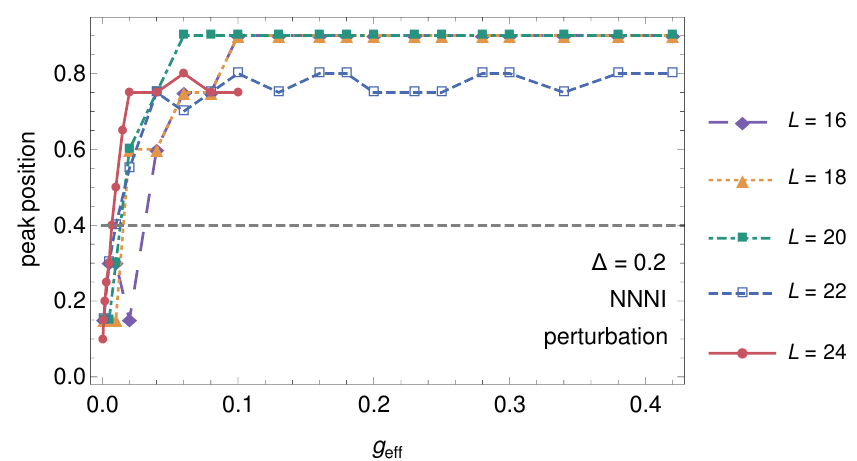
Figure 5: The position of the peak of the level spacing distribution corresponding to H for ∆ = 0.2 as a function of the effective coupling g for different chain NNNI eff = (cid:112) 2 /π is the position of the lengths L . The dashed grey line marks x , where 2 x 0 0 maximum of the exact Wigner-Dyson distribution. The transition from Poissonian to Wigner-Dyson statistics is faster for longer chains, as expected.